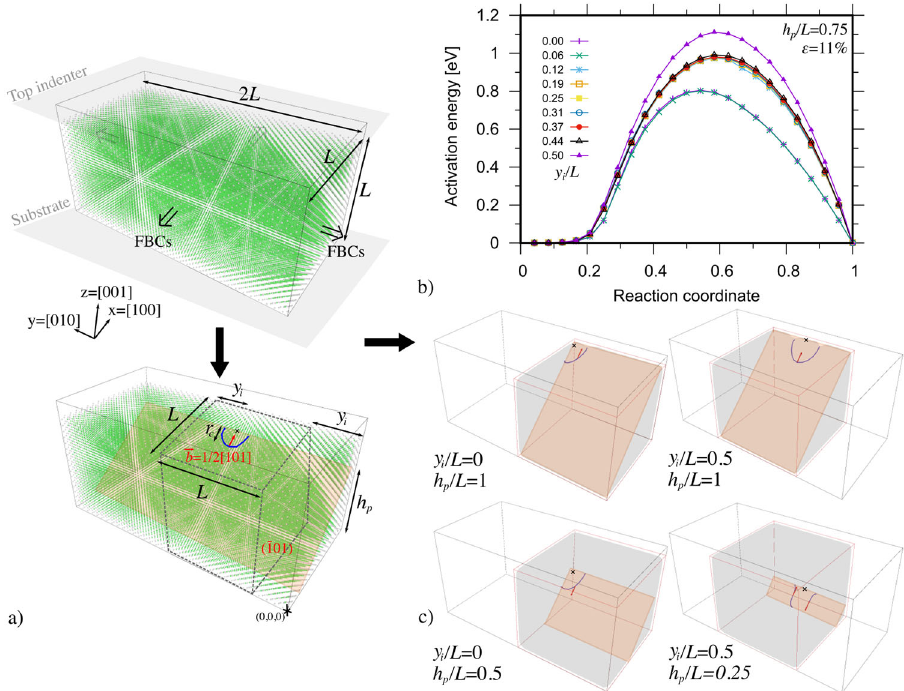
Fig. 2 Modeling surface dislocation nucleation in MgO nanocubes using a multi-step NEB approach. a Illustration of the fi rst NEB step performed on a 2 L long MgO nanowire with a square section of edge L constrained by two force fi elds i.e. the top indenter and the substrate [101]( 101 ) dislocation half-loop (line and Burgers vector are (top image). The saddle point con fi guration (bottom image) is characterised by a 1 2 shown in blue and red, respectively) emitted at ( L , L , h p ), from the back surface. Only Mg atoms are shown for the sake of clarity (fcc and surface atoms are coloured, respectively, in green and light-grey). The original simulation cell of the nanowire (before loading) is shown using grey-solid lines. The grey-dashed lines refer to a typical nanocube, carved out to compute the site dependence of the surface dislocation nucleation energy barriers during the second NEB step. b Examples of surface dislocation nucleation energy barriers in a nanocube for y i / L ranging from 0 to 0.5 and h p / L = 0.75. c Examples of con fi gurations for dislocation nucleation events from a corner ( y i / L = 0, h p / L = 1), from the mid-top edge ( y i / L = 0.5, h p / L = 1), the mid-side edge ( y i / L = 1, h p = 0.5) and the lower mid-surface region ( y i / L = 0.5, h p / L =